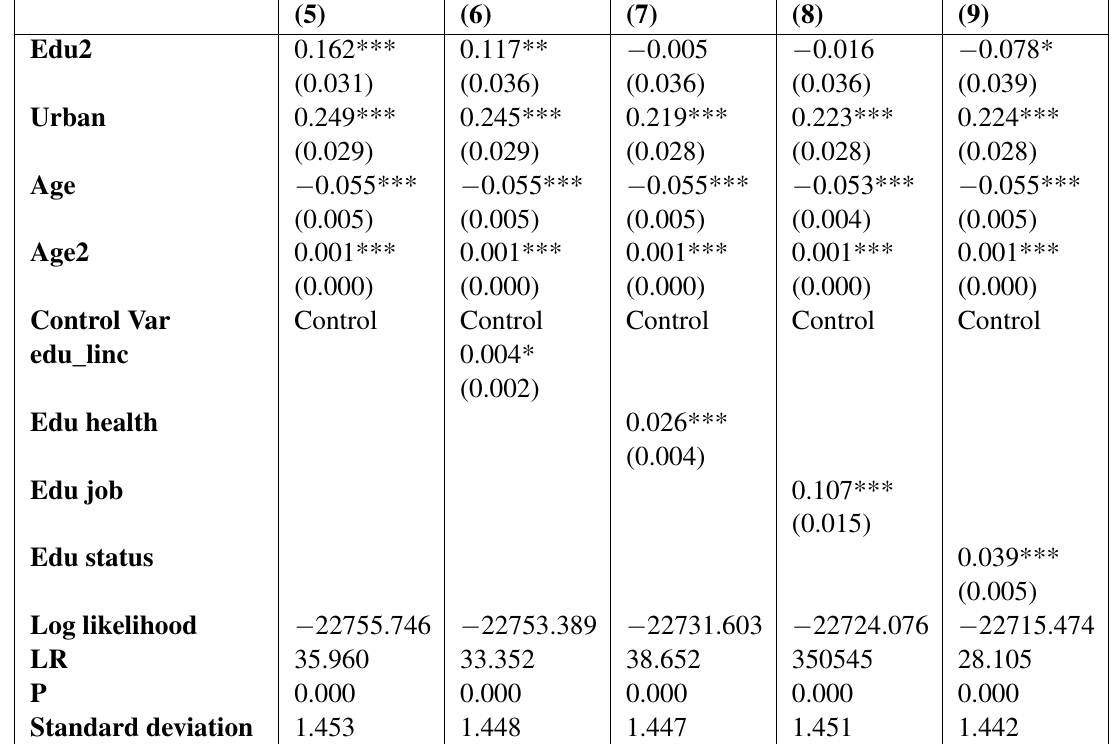
Table 3 Introducing cross-terms to determine the impact path